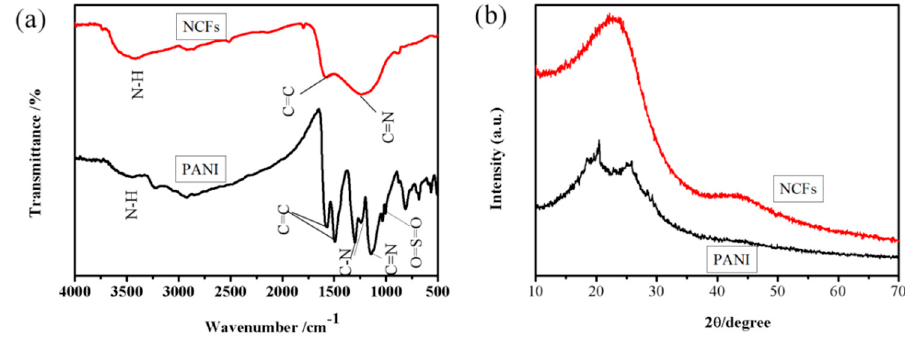
Figure 5. ( a ) FT-IR spectra and ( b ) XRD patterns of samples.